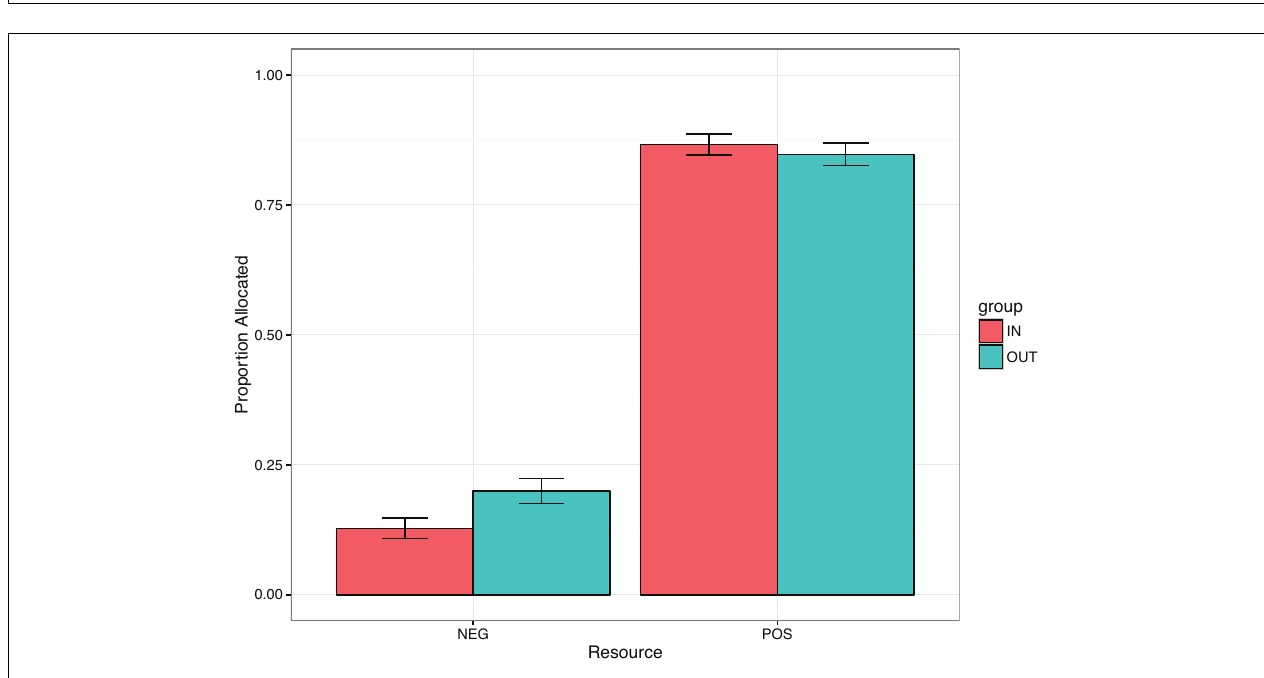
FIGURE 2 | Proportion allocated on Care trials by Distribution and Group. Error bars show binomial confidence intervals.